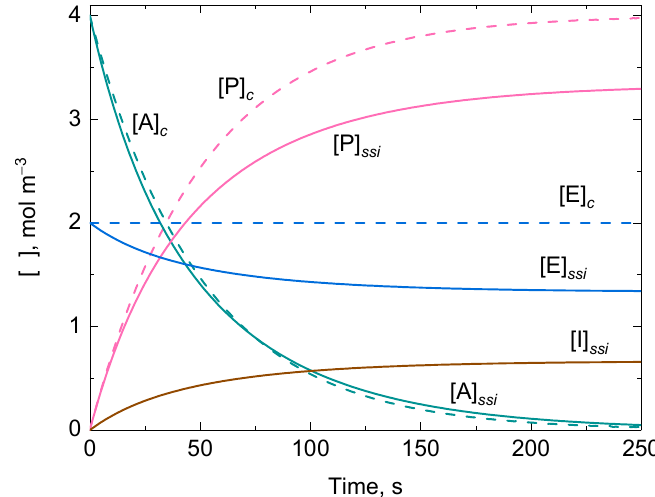
Figure 2. Representative approximate analytically integrated solutions of the time-dependent vari- ation of the concentration for the participating compounds of an irreversible uni–uni Michaelis– Menten model in the absence (dashed lines, subscript c ) and presence of suicide substrate inactivation (solid lines, subscript ssi ) following a one-step mechanism. Initial conditions: = 4 mol · m − 3 , [ A ] 0 [ E ] = 2 mol · m − 3 , k a = 10 − 2 m 3 · ( mol · s ) − 1 , and k = 2 × 10 − 3 m 3 · ( mol · s ) − 1 i 0